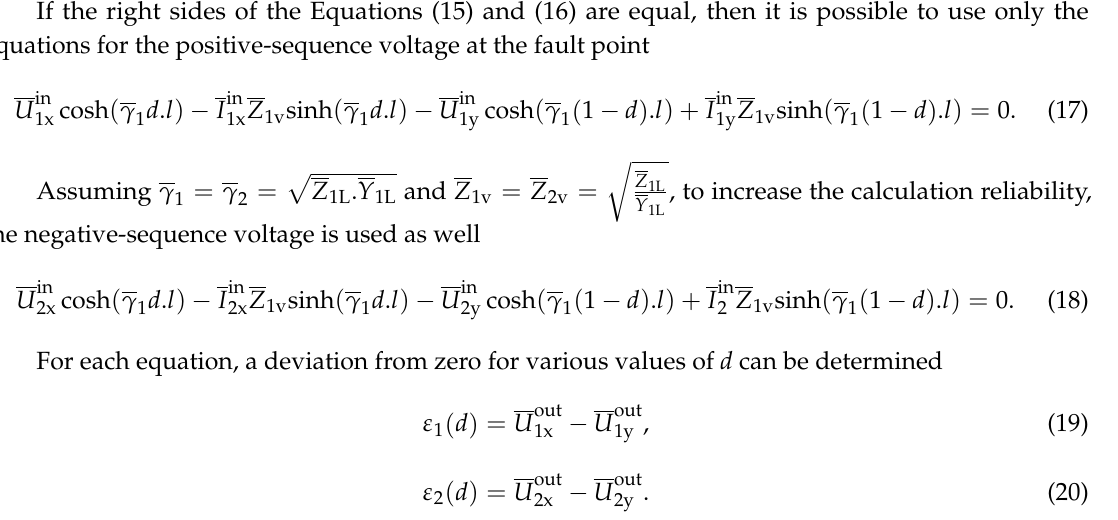
Figure 4 . An equivalent circuit for a single-phase fault. Figure 4. An equivalent circuit for a single-phase